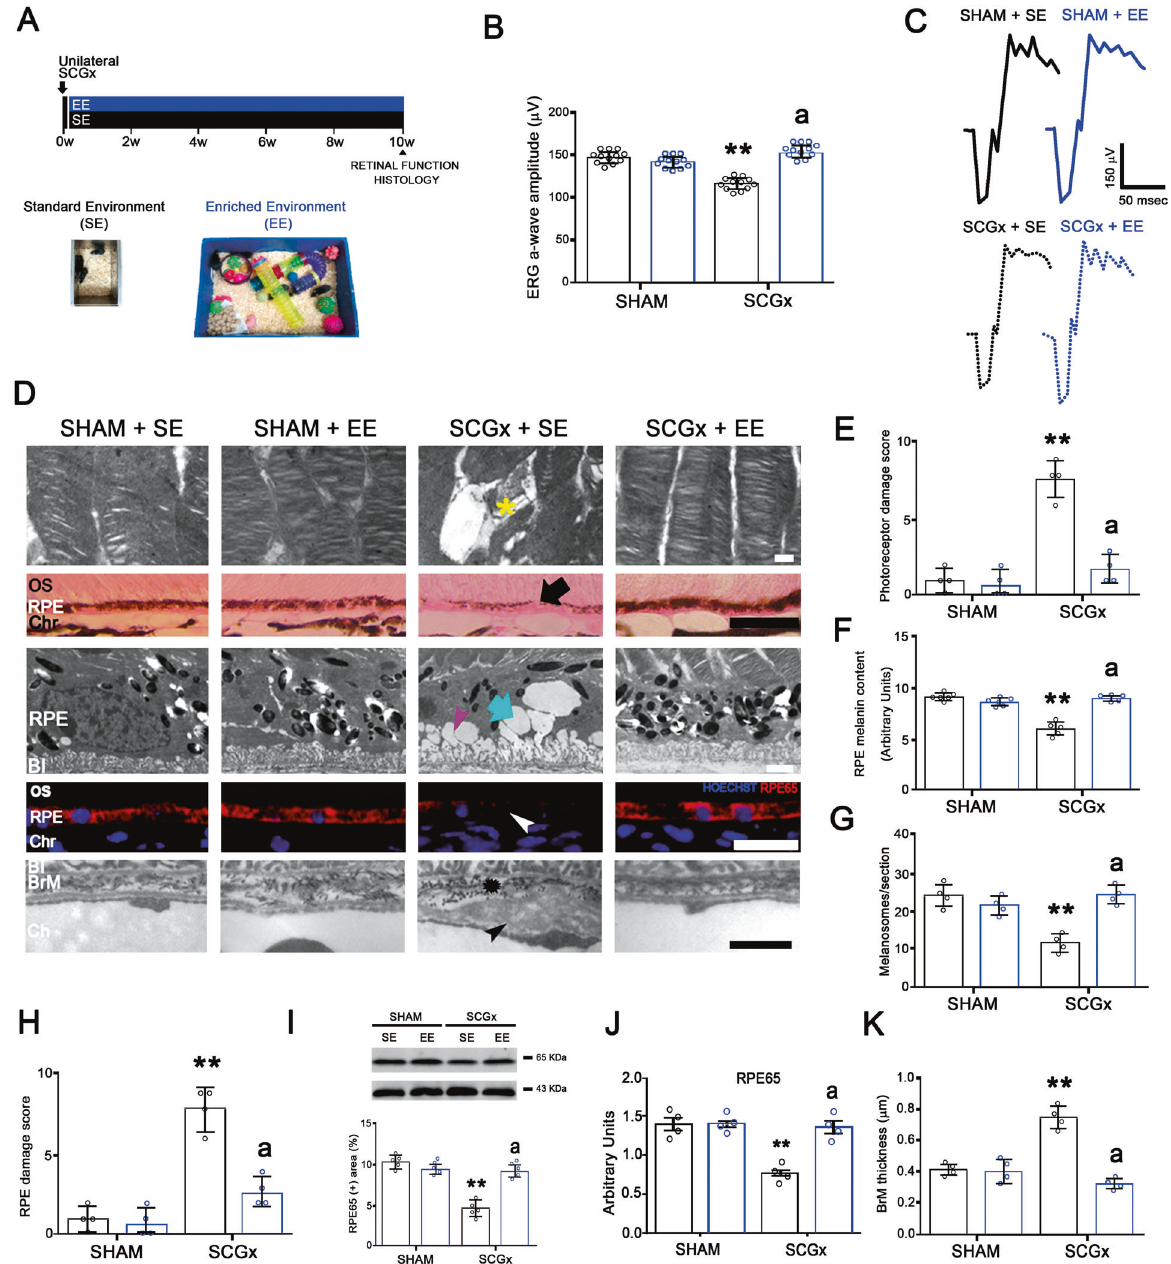
Fig. 1 Effect of EE on the retinal dysfunction and histological alterations at 10 weeks post-SCGx. A Experimental protocols. B SCGx induced a signi fi cant decrease in ERG a-wave amplitude in animals housed in SE, whereas EE starting 48 h post-SCGx, which had no effect per se, completely prevented the decrease in this parameter (representative traces shown in C ). Data are mean ± SEM ( n : 12 animals per group), ** P < 0.01 vs. sham-treated eyes from SE animals; a: P < 0.01 vs. SCGx-treated eyes from SE animals, by Tukey ’ s test. D In animals housed in SE, SCGx induced focal losses of PR discs (yellow asterisk) and blebs (quanti fi ed in E ), and a decrease in RPE melanin content (black arrow) and melanosome number at the central temporal RPE, which were completely prevented by EE (quanti fi ed in F and G ). EE also prevented RPE vacuolization (cyan arrow) and basal infolding thickening (magenta arrowhead) (quanti fi ed as RPE damage score in H ), as well as the decrease in RPE65-immunostaining (white arrowhead) and protein levels at the temporal RPE at 10 weeks post-SCGx (quanti fi ed in I and J ). SCGx induced BrM thickening (quanti fi ed in K ), a clear loss of its pentalaminar structure (asterisk) and thickening of the endothelial cell basal membrane (black arrowhead), which were prevented by EE. Shown are representative photomicrographs from 5 (for optic microscopy) and 4 (for electronic microscopy) eyes/group, at 800 μ m temporally from the ONH. OS photoreceptor outer segments, RPE retinal pigment epithelium, BI RPE basal infoldings, BrM Bruch ’ s membrane, Ch choriocapillaris, Chr choroid. Scale bars = 500, 20, 25, 1.5, 300 nm. Data are mean ± SEM ( n : 5 (for optic microscopy) and 4 (for electronic microscopy) eyes per group), ** P < 0.01 vs. sham-treated eyes from SE animals; a: P < 0.01 vs. SCGx-treated eyes from SE animals, by Tukey ’ s test. Data are mean ± SEM ( n : 5 homogenates per group), ** P < 0.01 vs. sham-treated eyes from SE animals, by Tukey ’ s